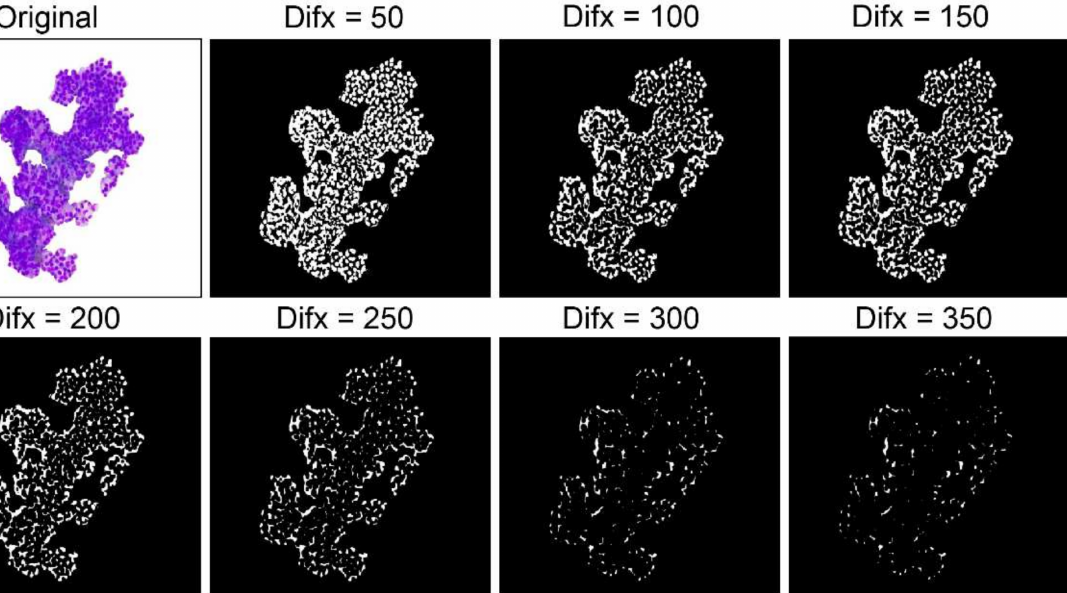
Figure 4. The reaction–diffusion images with different D values: As the D value decreased, the unnecessary parts of the edges became visible, instead of the core content. In contrast, as the D value increased, the unnecessary parts of the edges disappeared, while the content showed a tendency to almost disappear.